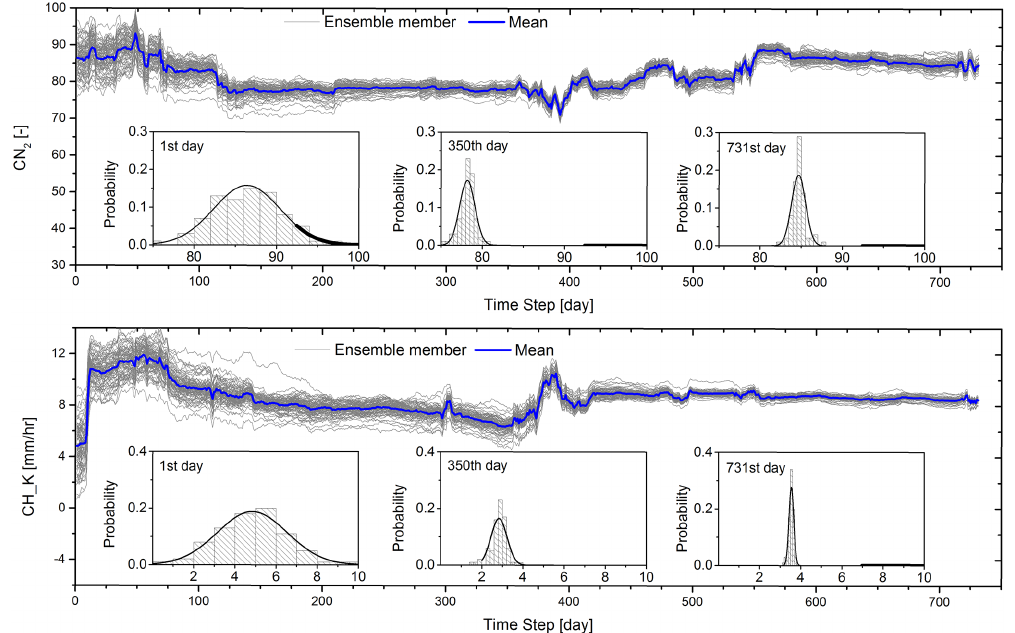
Figure 4. Estimations of two typical parameters (CN 2 and CH_K) from the ASS_D scenario. The histograms in each plot, fitted with the Gaussian distribution function, represent the ensemble distribution at three time steps.